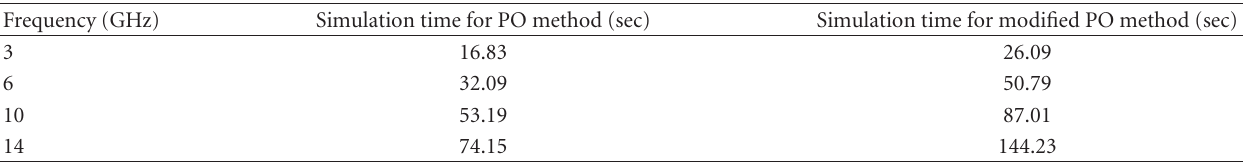
Table 1: Comparison of CPU simulation